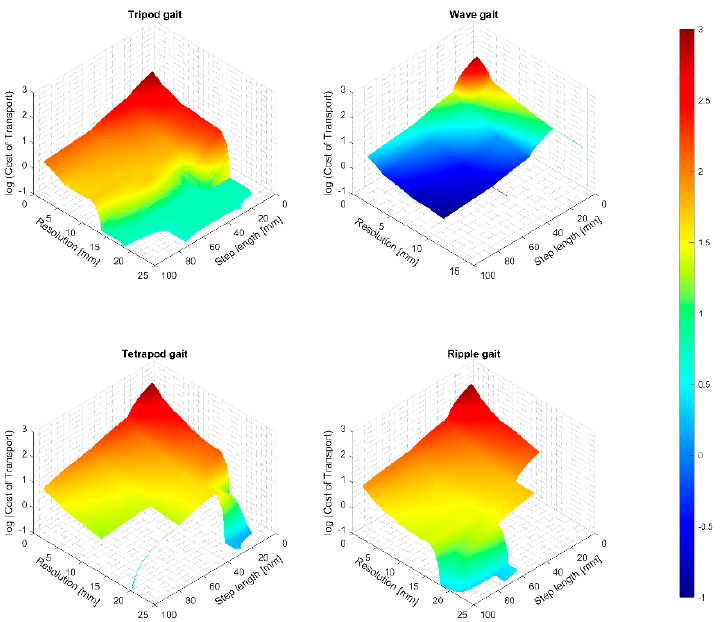
Figure 8. Comparison of Cost of Transport upon gait type, gait step length, and resolution.